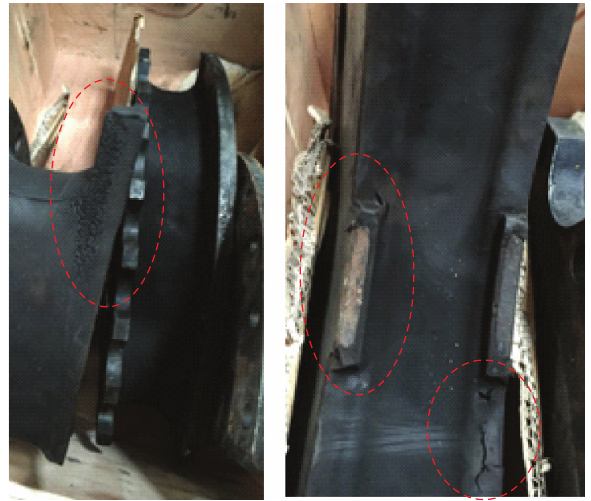
Figure 1: Elastic